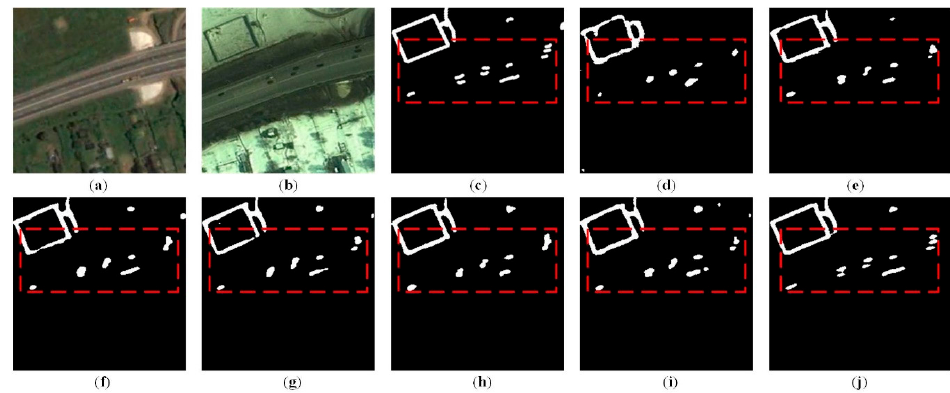
white while the unchanged parts are in black.